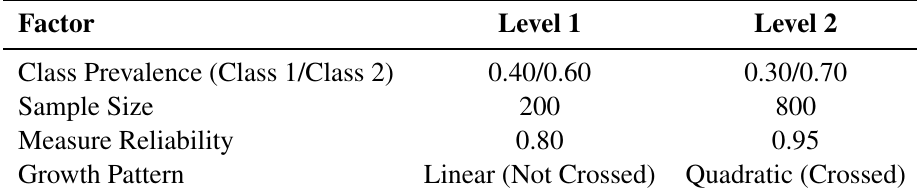
Table 1. Design factors for the Monte Carlo study.